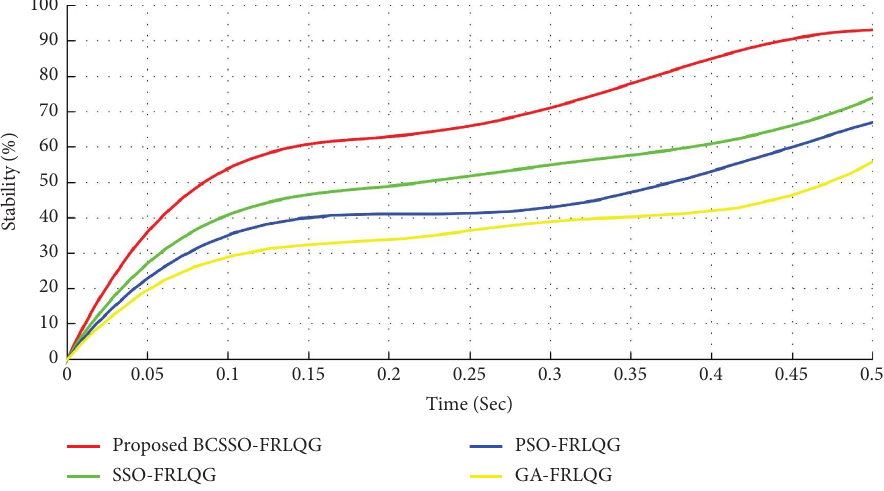
Figure 10: Stability enhancement analysis.